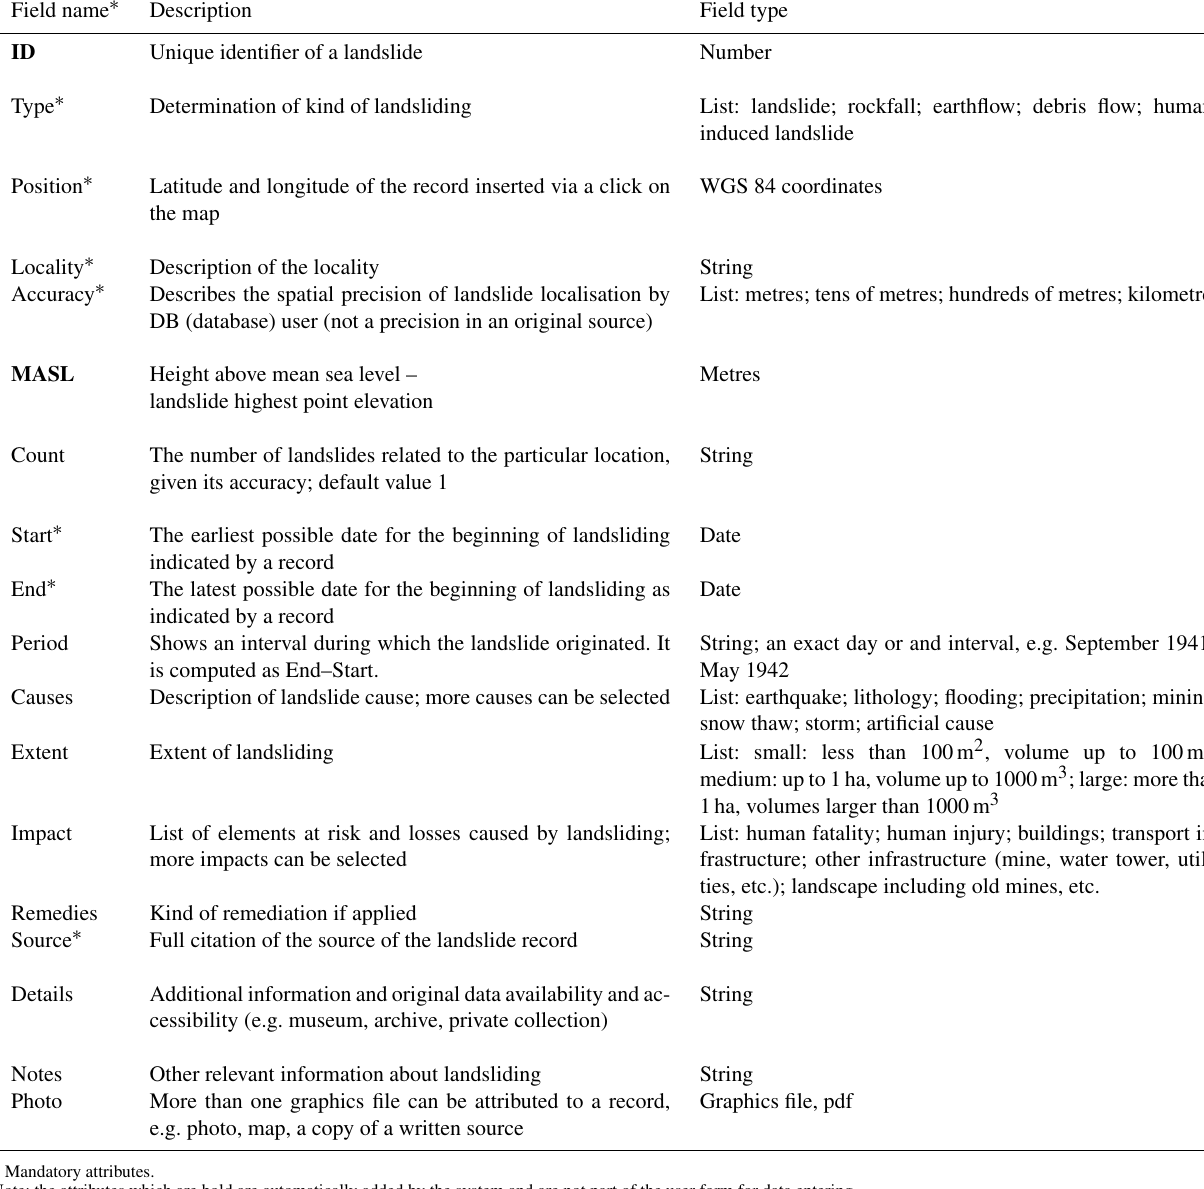
Table 1. Structure of records in